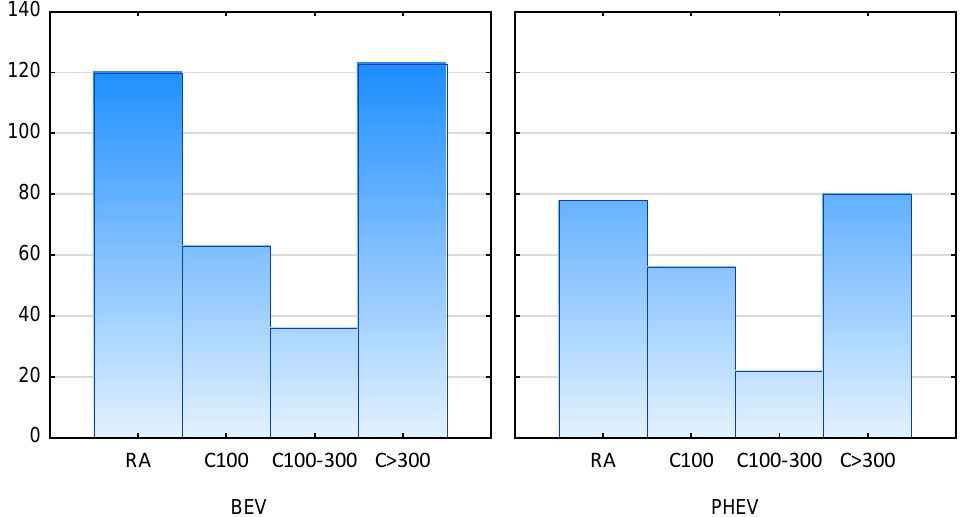
Figure 4. Categorized data histogram showing respondents’ opinions by gender in terms of BEV or PHEV vehicle type.